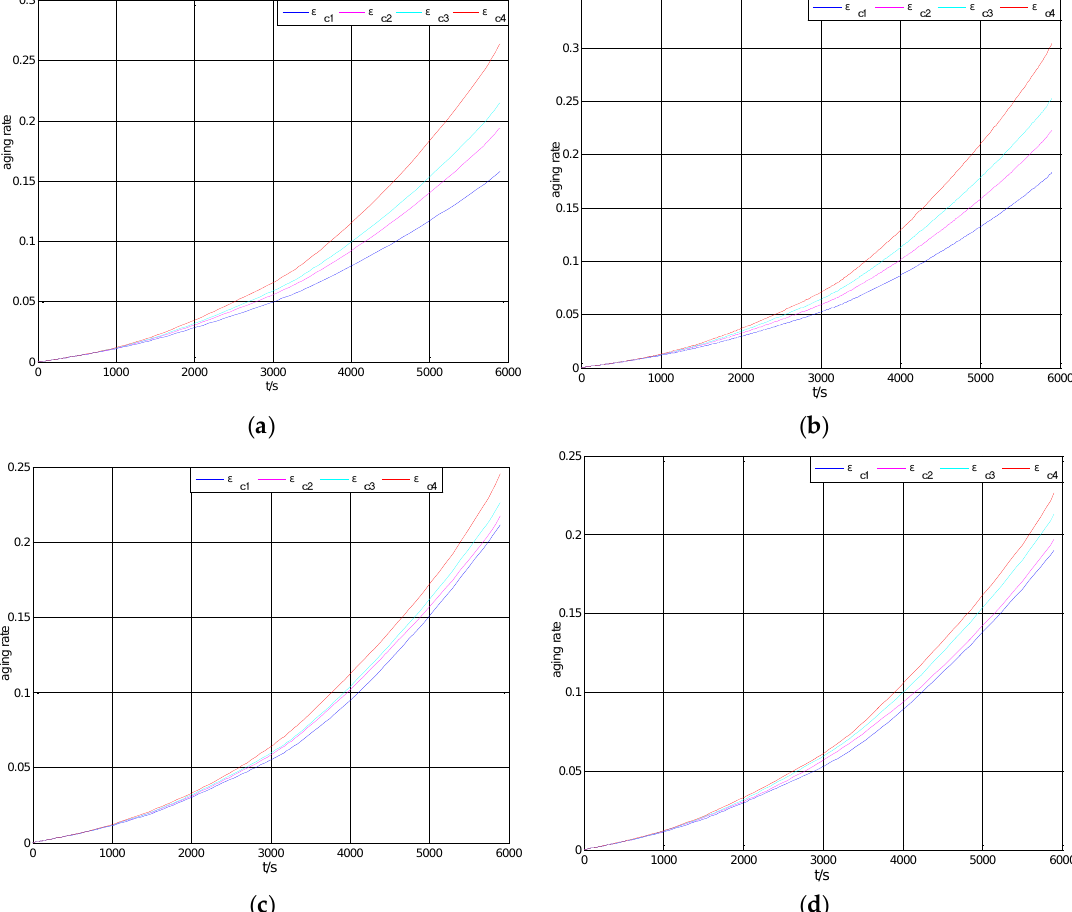
balancing control; ( b ) SOC balancing control; ( c ) Multi-objective balancing control; ( d ) MOPBC.